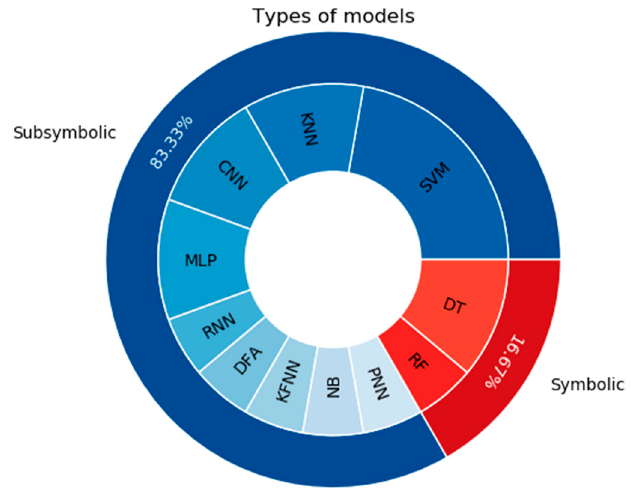
Figure 3. Pie chart of the network types usage.